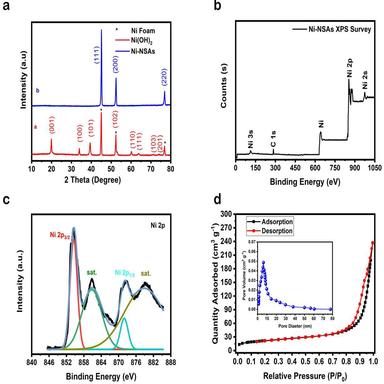
Illustrates (a) XRD patterns of Ni(OH)2-NSAs@Ni foam and Ni-NSAs, (b) XPS survey spectra of Ni-NSAs, (c) High resolution XPS spectra of Ni 2p and (d) BET data of Ni-NSAs.